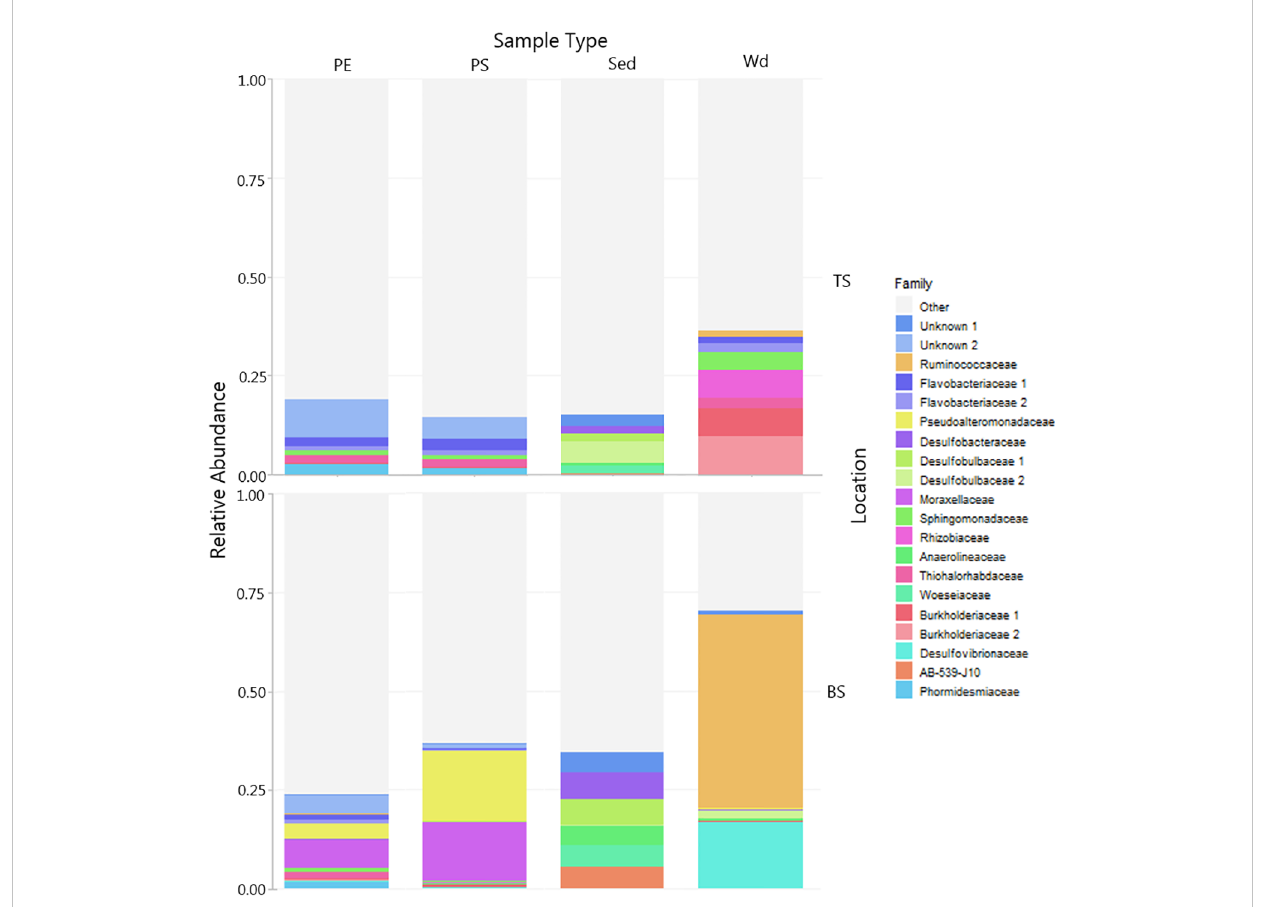
FIGURE 8 Microbial community associated with PE and PS and wood controls in sediment compared to microbial community in the surrounding bulk sediment (Sd – TS, BS). The relative abundance of the top 20 ASVs colored by family. Plastics and wood controls were exposed for 6 months in top sediment (TS, 0-2cm, oxic) and bottom sediment (BS, >4cm anoxic). Note samples are divided by sample type (PE, PS, Sed, Wd) and location (BS, TS). Grey shaded areas are other taxa outside the top 20 abundant